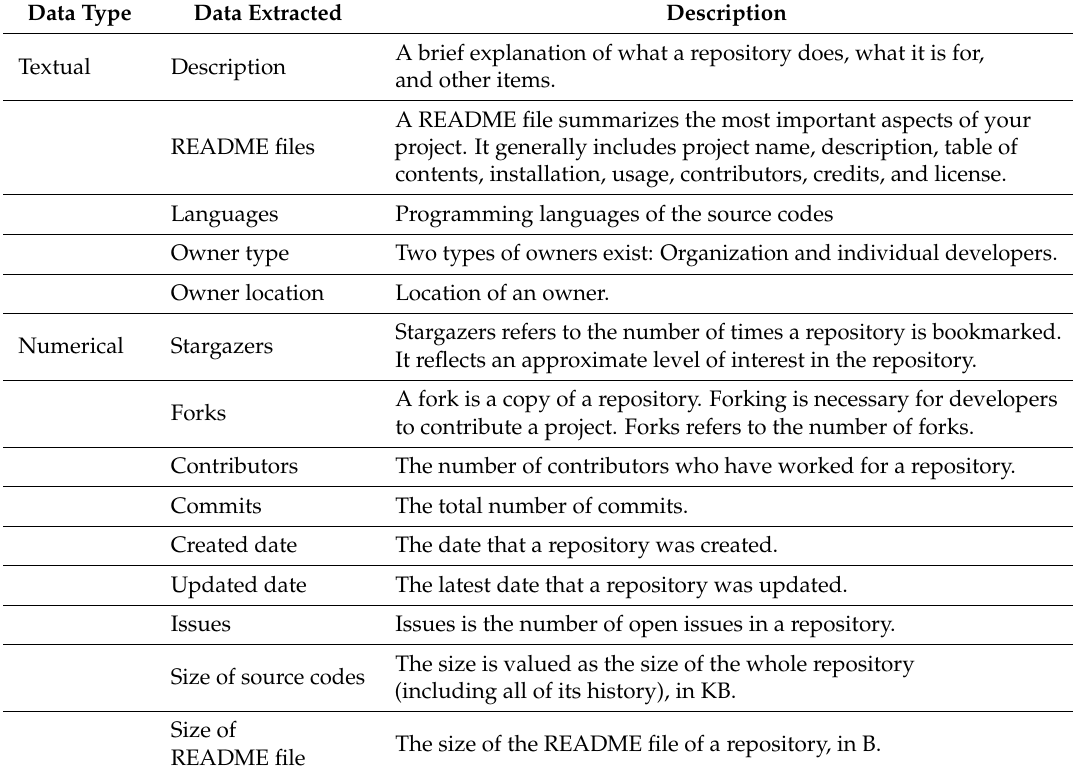
Table 1. Data extracted from GitHub REST API